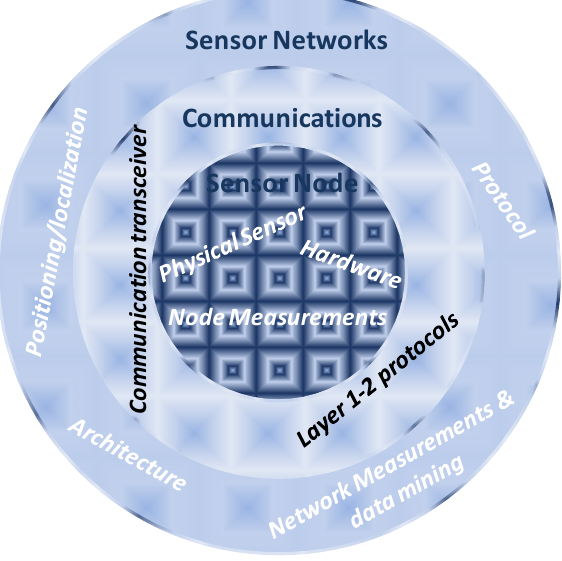
Figure 2. Classification of the topics into